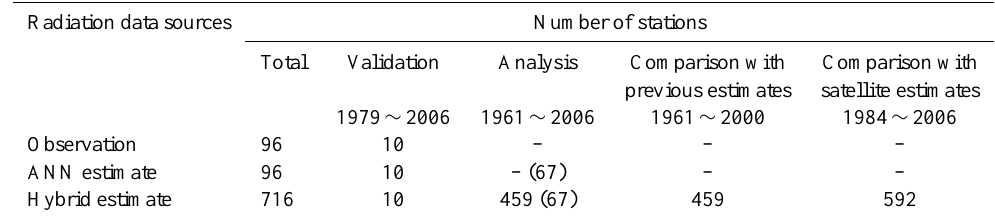
Table 2. The numbers of the stations for different purposes during different time periods in this study. The numbers in parentheses are for the comparison of trend estimates between ANN and the hybrid